Question: State the chart type depicted above.
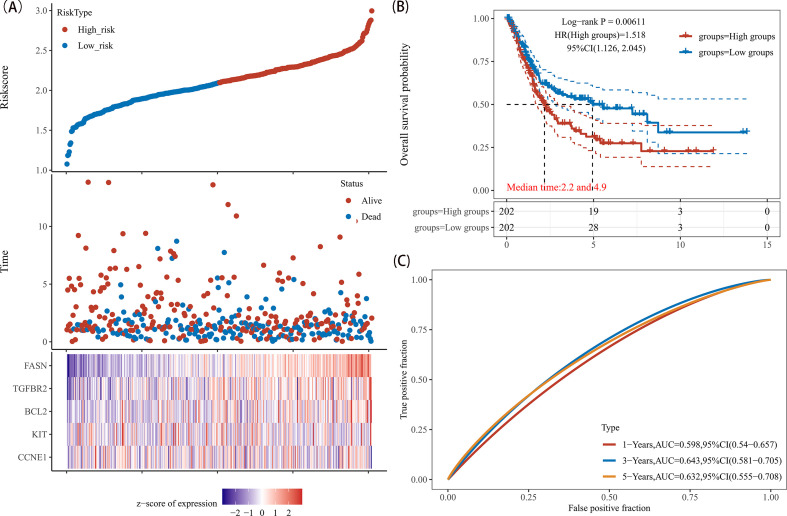
Answer: heatmap